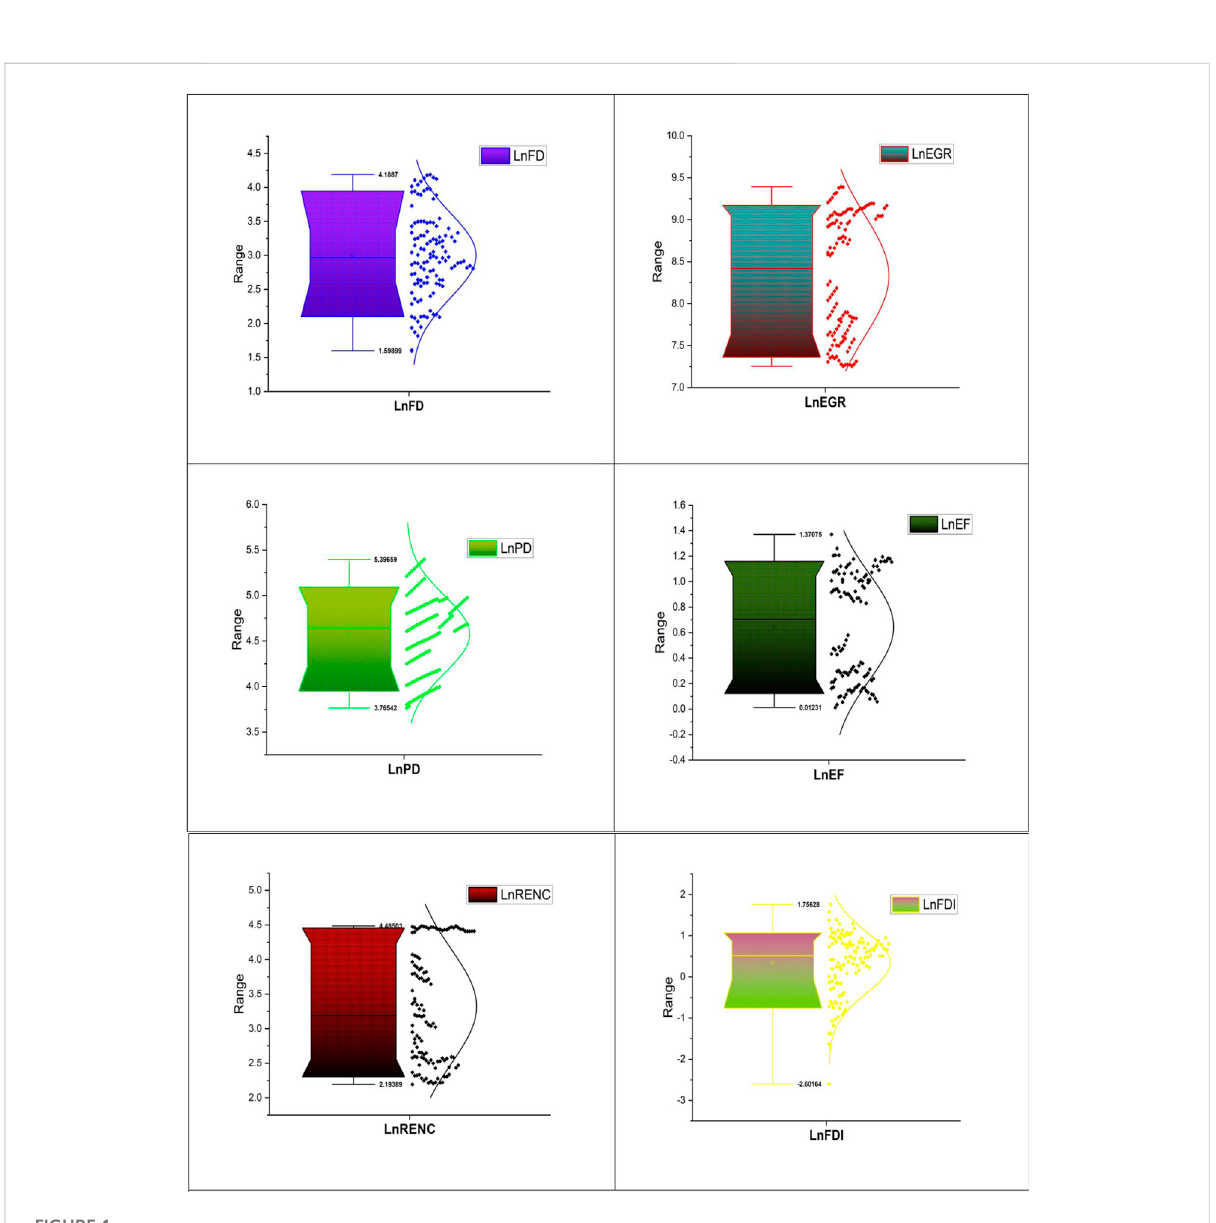
FIGURE 1 Box-plot of the variables of